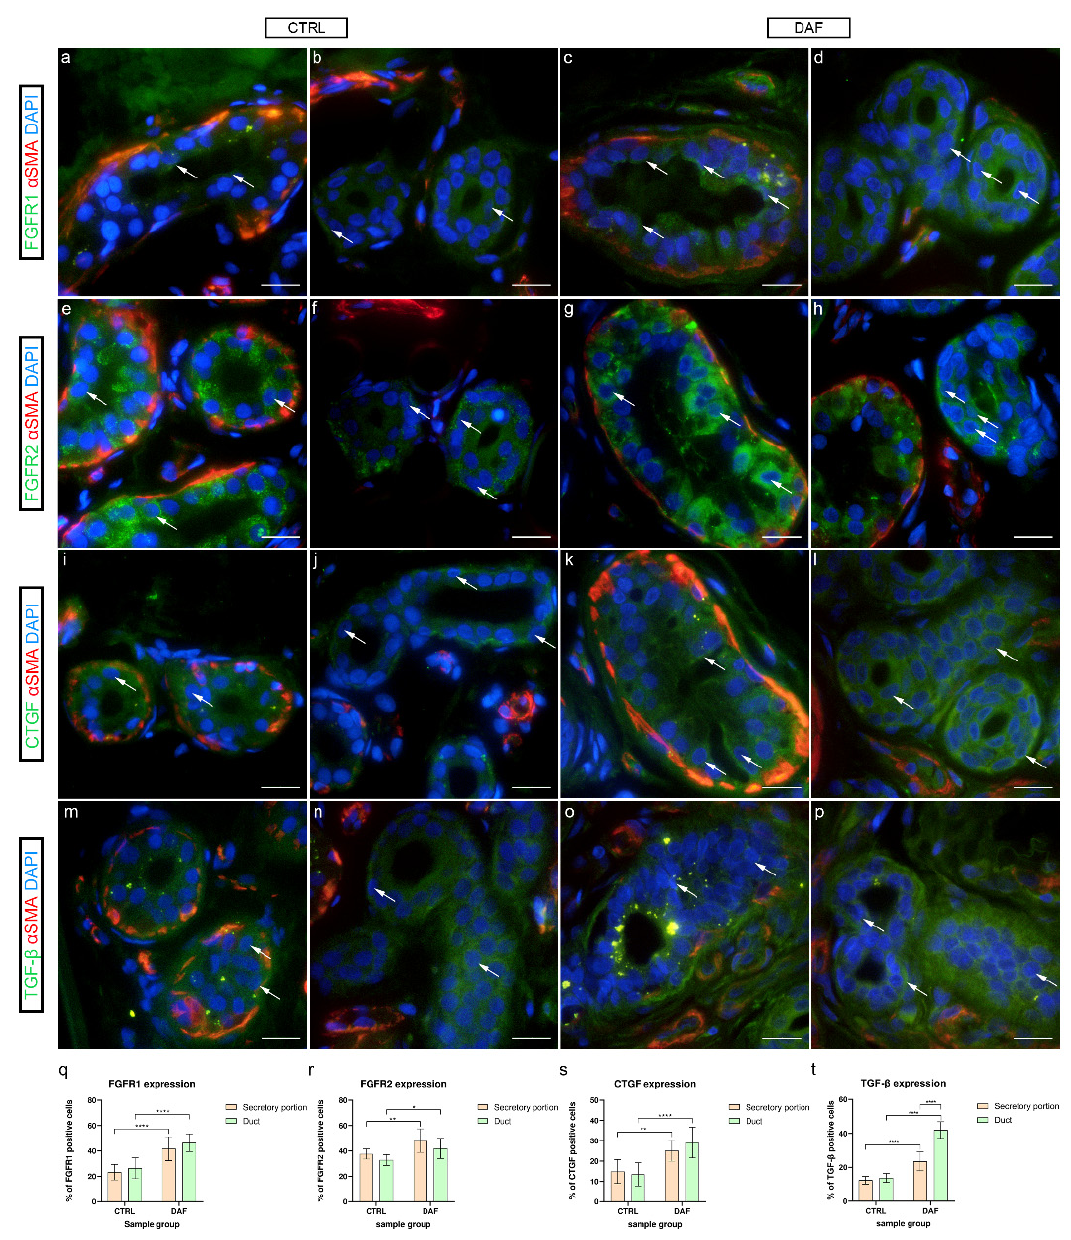
Figure 8. Co-expression of FGFR1/FGFR2/CTGF/TGF- β and α -SMA in eccrine sweat glands of healthy controls and patients with DD. CTRL–normal skin of healthy individuals ( a , b , e , f , i , j , m , n ); DAF–clinically affected palmar fascia of DD patients ( c , d , g , h , k , l,o , p ). FGFR1 expression is seen in sweat gland cells (arrows) of secretory portions ( a , c ) and ducts ( b , d ). FGFR2 expression is also seen in sweat gland cells (arrows) of secretory portions ( e , g ) and ducts ( f , h ). CTGF is expressed in sweat gland cells (arrows) of secretory portions ( i , k ) and ducts ( j , l ). TGF- β is also expressed in sweat gland cells (arrows) of secretory portions ( m , o ) and ducts ( n , p ); α -SMA staining shows myoepithelial cells of sweat gland secretory portions and sections through surrounding blood vessels ( a – p ). DAPI staining displays all cell nuclei ( a – p ). Double immunofluorescence staining to FGFR1/FGFR2/CTGF/TGF- β , α -SMA and DAPI, 1000 × magnification, scale bar 50 µ m. Graphs display statistically significant differences in FGFR1 ( q ), FGFR2 ( r ), CTGF ( s ), and TGF- β expression ( t ) between the analyzed samples. Error bars show standard deviation; * p < 0.05, ** p < 0.01, **** p <